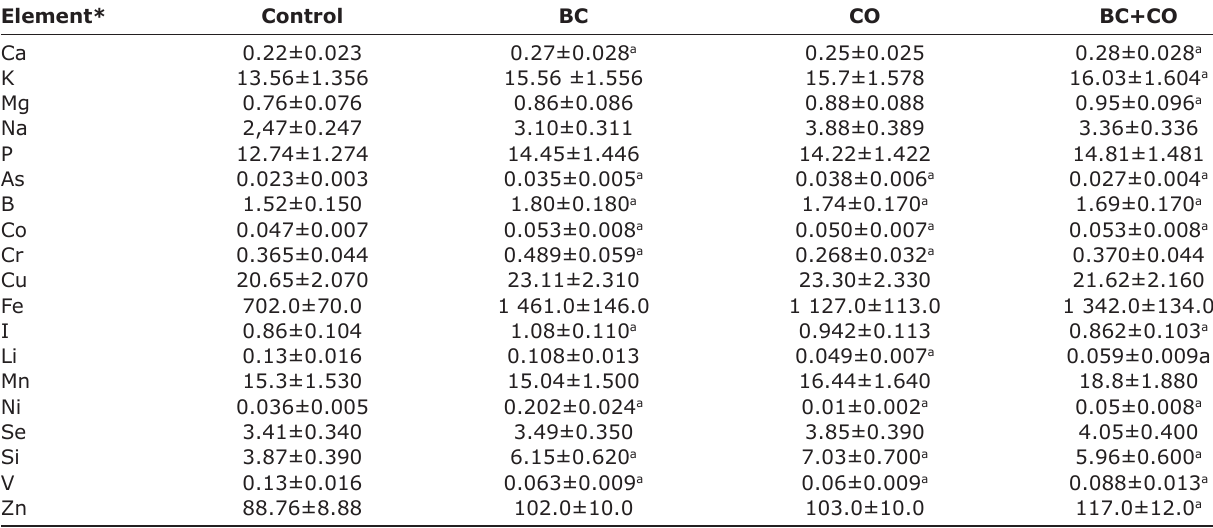
Table-6: The concentration of chemical elements in broiler liver with Bacillus cereus and coumarin in diets (day 42). Element*